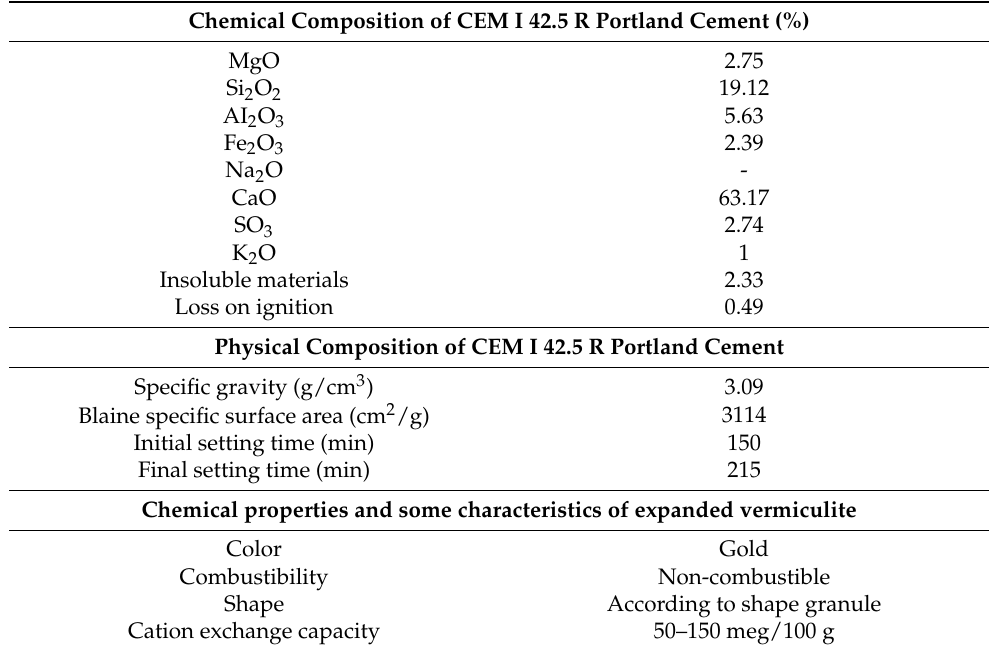
Table 1. Properties and characteristics of CEM I 42.5 Portland cement, expanded vermiculite, and silica